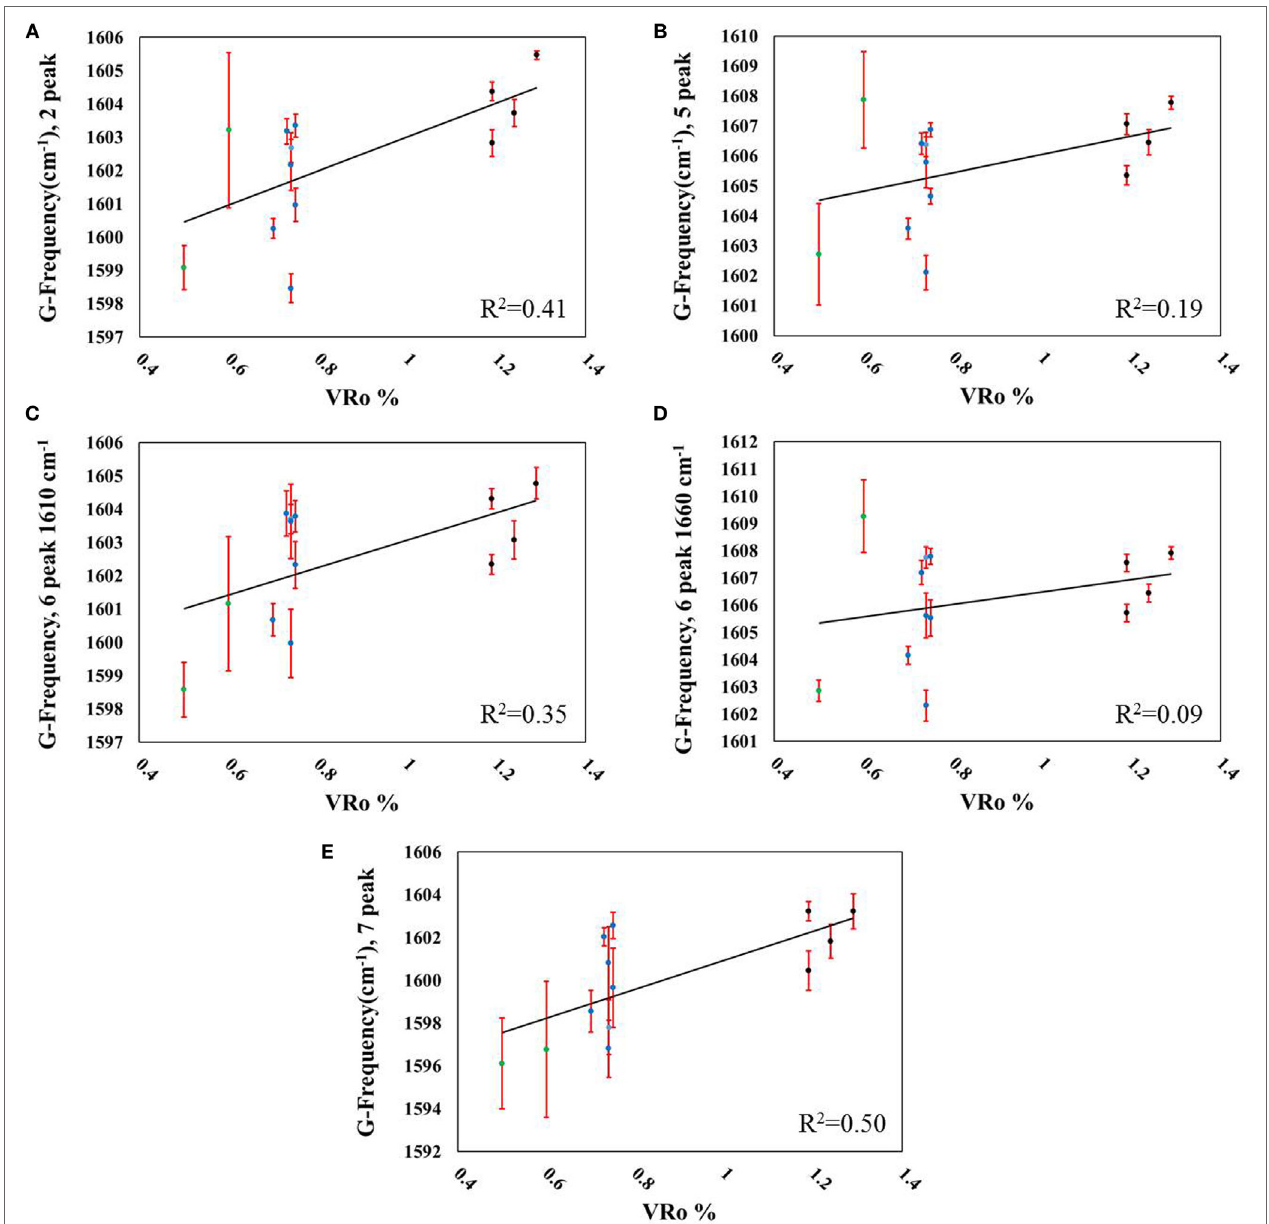
FigUre 5 | Correlations between G-band frequency and measured VRo% using (a) two peaks ( R 2 = 0.41), (b) five peaks ( R 2 = 0.19), (c) six peaks including the D2-band ( R 2 = 0.35), (D) six peaks including a ~1,660 cm − 1 peak ( R 2 = 0.09), and (e) seven peaks ( R 2 = 0.50). Data point legend: green = Aristech wells, blue = Interstate/Columbia wells, black = EQT